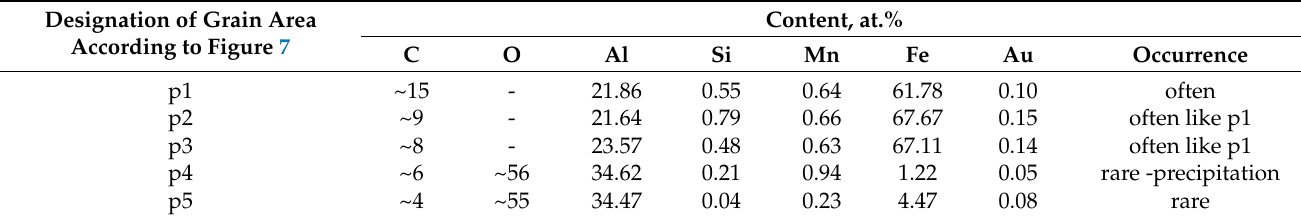
Figure 7. Microstructure of arc-sprayed Fe-Al-type intermetallic coating after annealing at 900 ◦ C for 2 h with hypothetical phase identification based on results of EDS point analysis (in Table 3). Table 3. Chemical composition of as-arc-sprayed Fe-Al-type coating after annealing at 900 ◦ C/2 h based EDX point microanalysis according to Figure